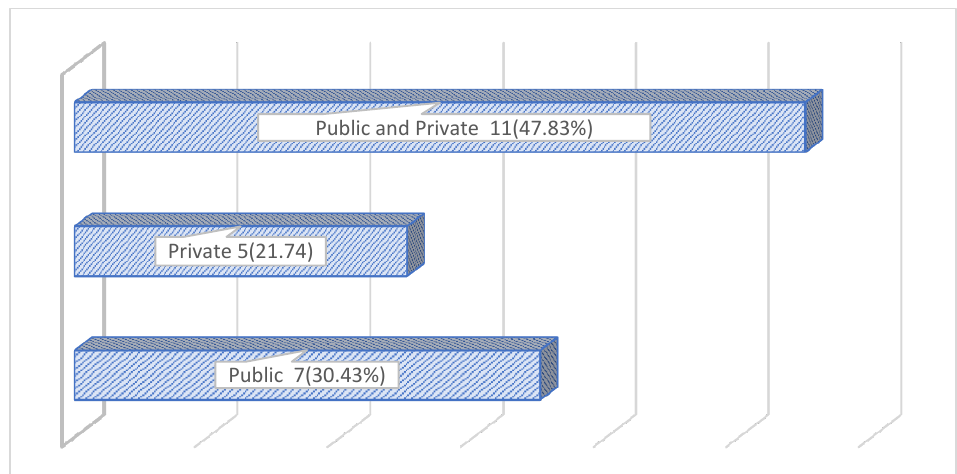
Figure 3. Labour sector of the study participants (n = 23).